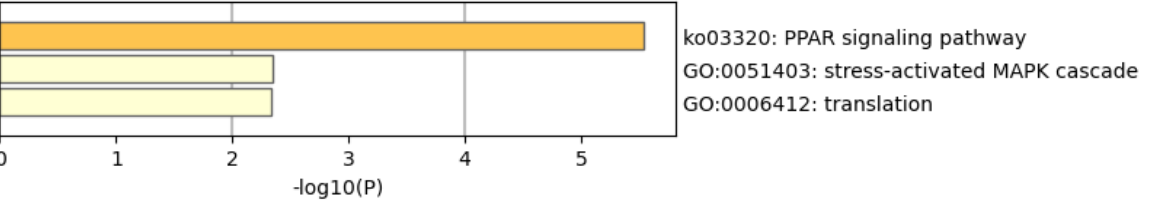
Figure 3. Enrichment results of the selected 60 up-regulated DEG comparing WTC vs. ISO. Functional gene set enrichment analysis was performed on the 60 DEGs that were up-regulated in WTC compared with ISO group at both day 360 (with p < 0.05) and day 240 (with p < 0.1).